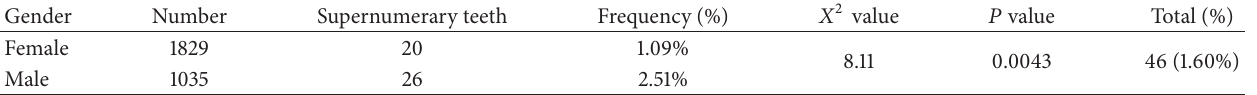
Table 1: The prevalence and distribution of supernumerary teeth in males and females.